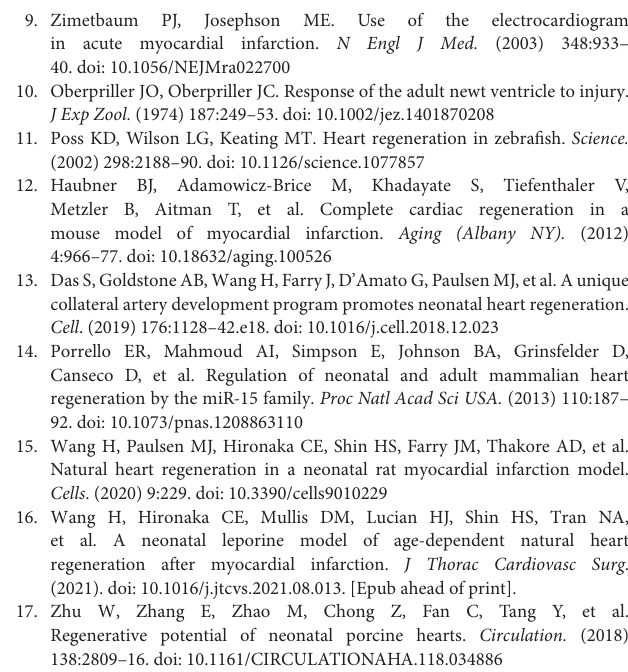
Supplementary Figure 1 | Area at risk after left anterior descending coronary artery ligation in neonatal piglets. Immediately following ligation of the left anterior descending coronary artery, the myocardial area at risk (AAR) was calculated as a percentage of the entire left ventricle (LV) by weight using Evans blue staining, revealing no significant difference in AAR after surgery on postnatal day 1 (P1) vs. postnatal day 7 (P7). Supplementary Figure 2 | Correlation between QRS length and degree of left ventricular fibrosis after myocardial infarction in neonatal piglets. A scatterplot of QRS length vs. degree of left ventricular (LV) fibrosis is shown, including healthy controls (blue) and piglets at 7 weeks after myocardial infarction on postnatal day 1 (P1, green) and postnatal day 7 (P7, yellow). A direct relationship is observed between QRS length as a linear function of LV